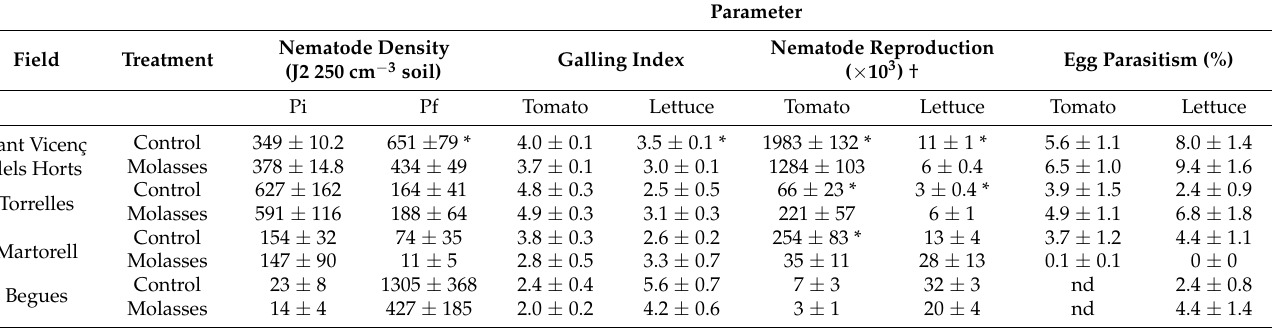
Table 3. Effect of 1 mL m − 2 of molasses application just after crop transplantation and 15 and 45 days later on nematode densities in soil (Pi; Pf) and in roots (nematode reproduction), disease severity (galling index), and egg parasitism (%) in the intercropped tomato cv. Durinta at the end of the first nematode generation, and the lettuce cv. Paraday at the end of the crop in four organic vegetable production sites.